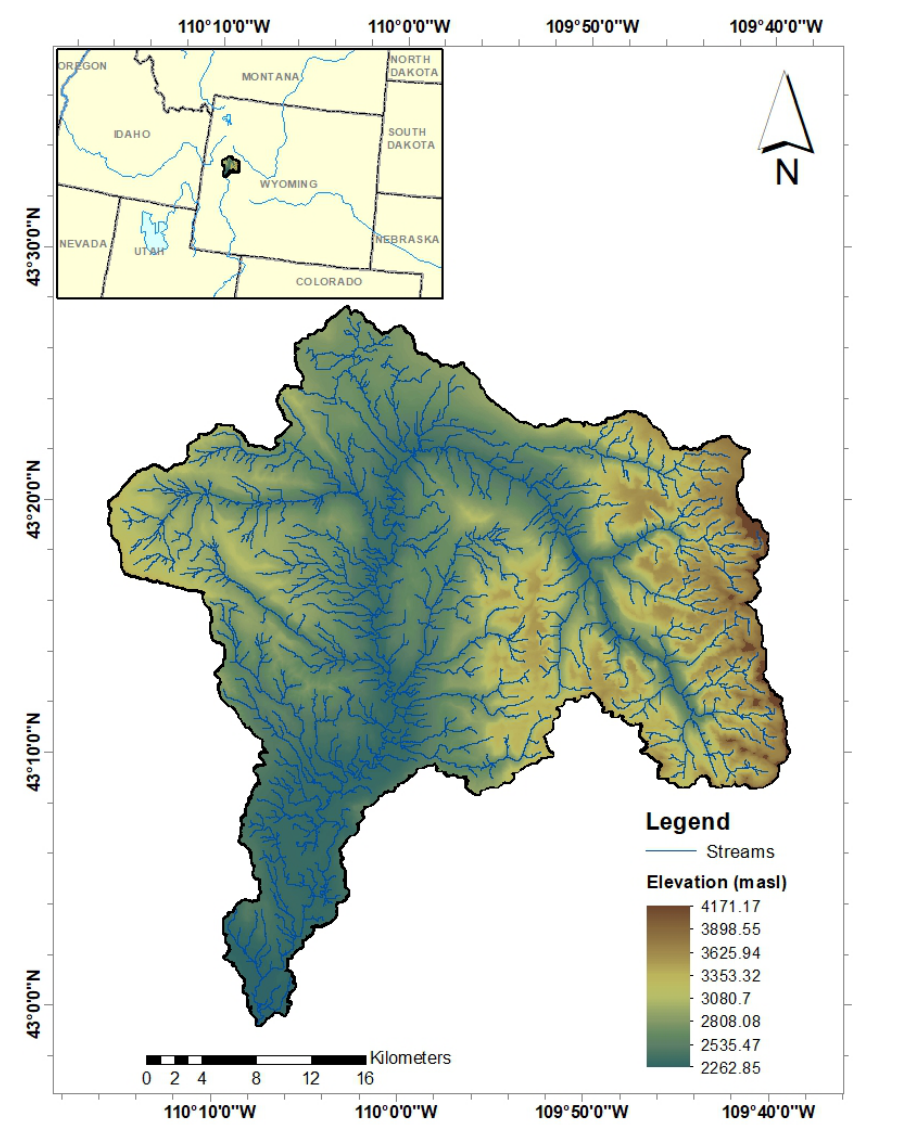
Figure 1. General location of the uppper Green River basin, a major tributary to the Colorado River within the state of Wyoming in the United States of America. The figure also shows a DEM with elevations and stream channel